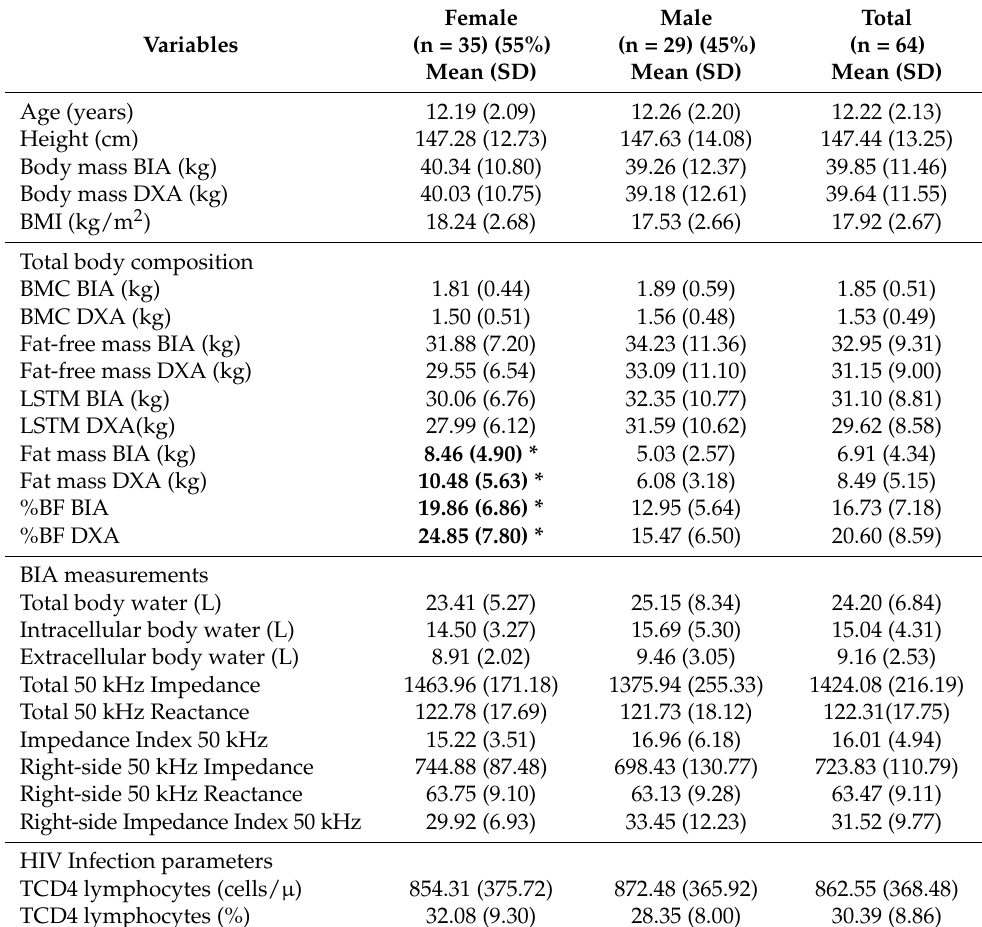
Table 1. Study subjects physical and biological